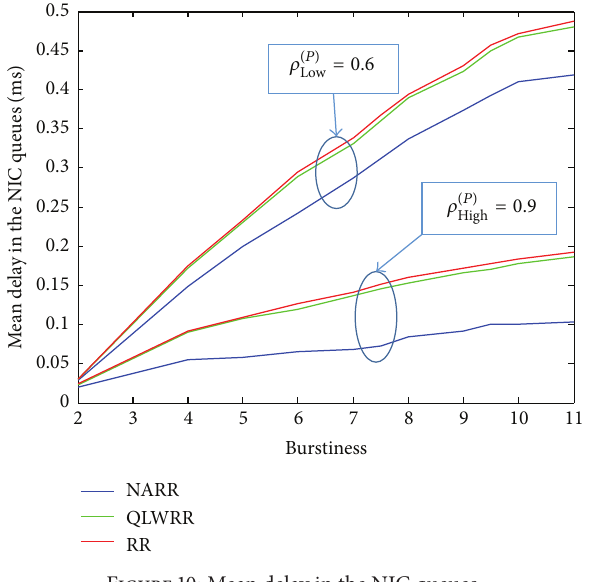
Figure 10: Mean delay in the NIC queues.